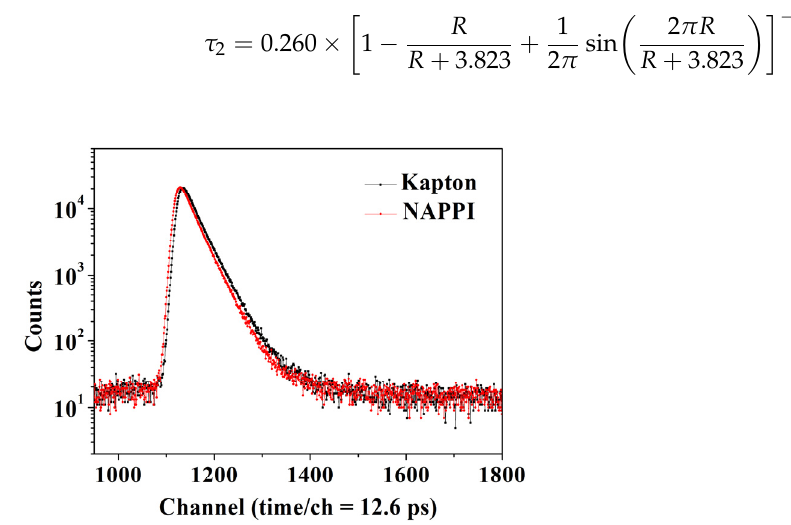
Figure 8. Positron lifetime spectra of Kapton and NAPPI.